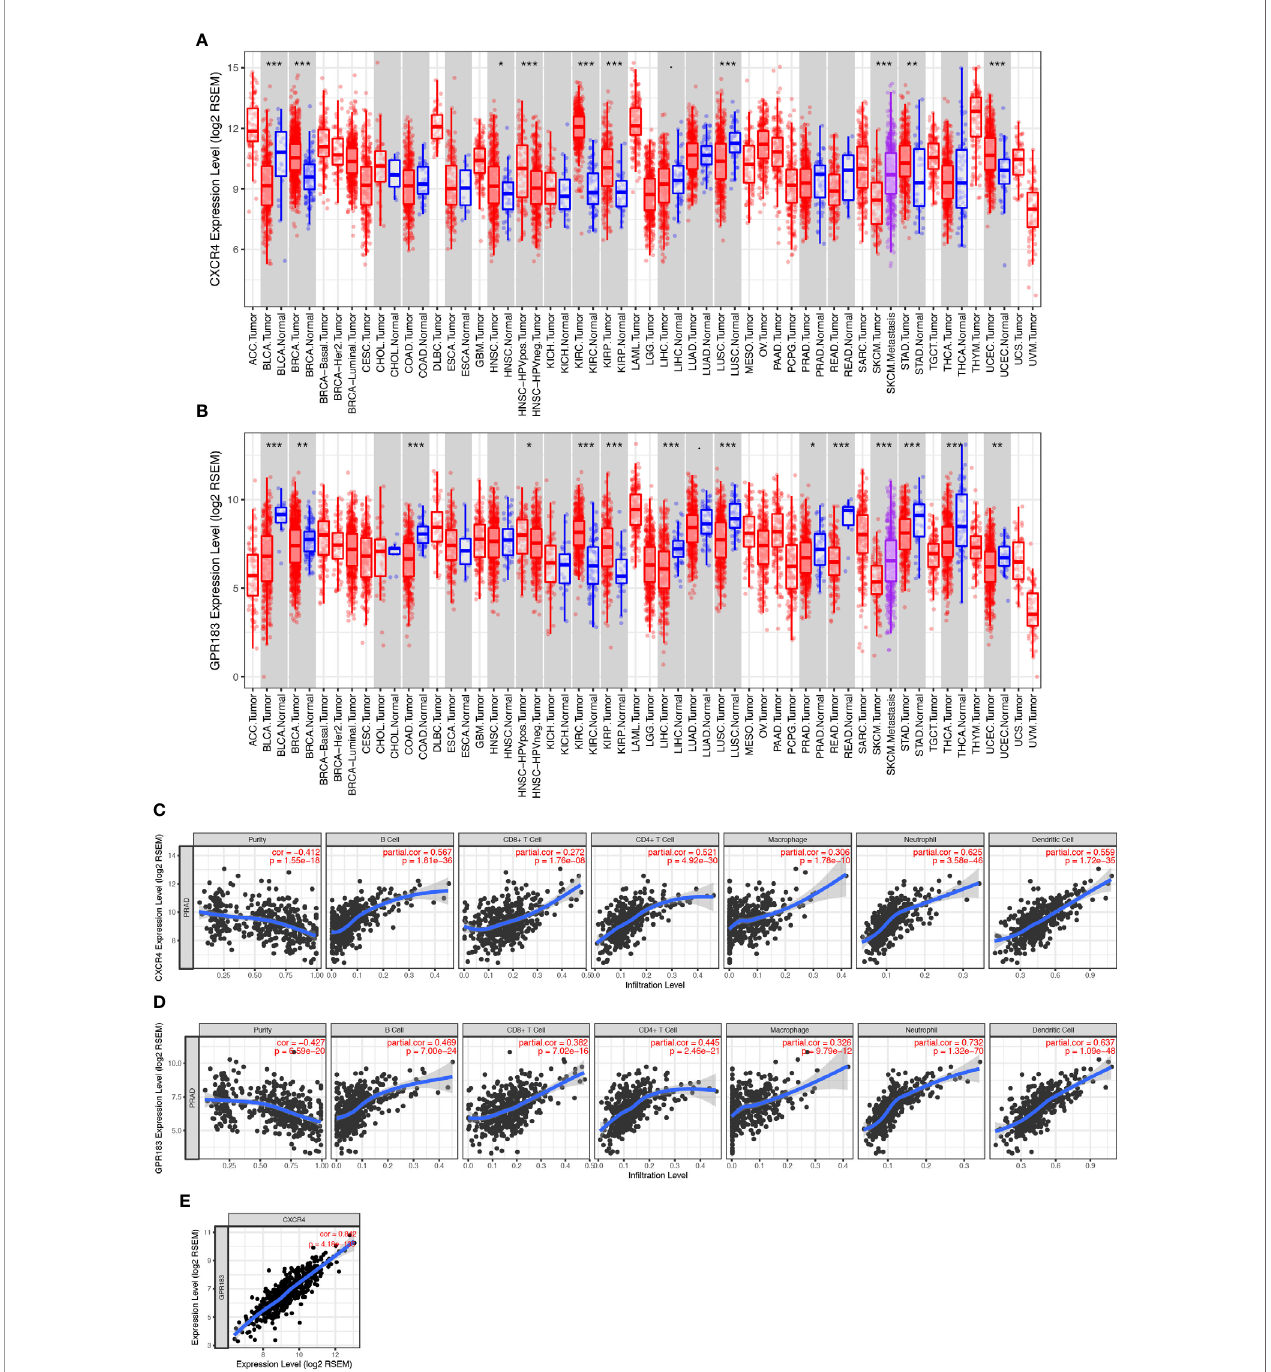
FIGURE 4 | CXCR4 and GPR183 correlated with immune cell in fi ltration in PCa tissue. (A) CXCR4 expression levels in different kinds of tumors and their control tissues according to the TCGA data, and there was no signi fi cant difference between prostate cancer tissue and its control normal tissue. (B) GPR183 expression levels in different kinds of tumors and their control tissues according to the TCGA data, and GPR183 was signi fi cantly decreased in prostate cancer tissue ( P < 0.05). (C) Correlation analysis on CXCR4 and the tumor purity (Correlation Index=-0.412, P < 0.001) and immune cell in fi ltration of prostate cancer. The higher expression level of CXCR4 in tumor tissue was accompanied by increased in fi ltrated B cells, CD8+ T cells, CD4+ T cells, macrophages, neutrophils, and dendritic cells ( P < 0.001). (D) Correlation analysis on GPR183 and the tumor purity (Correlation Index=-0.427, P < 0.001) and immune cell in fi ltration of prostate cancer. The higher expression level of CXCR4 in tumor tissue was accompanied by increased in fi ltrated B cells, CD8+ T cells, CD4+ T cells, macrophages, neutrophils, and dendritic cells ( P < 0.001). (E) The expression level of CXCR4 and GPR183 in prostate cancer tissue was highly correlated (Correlation Index=0.842, P <